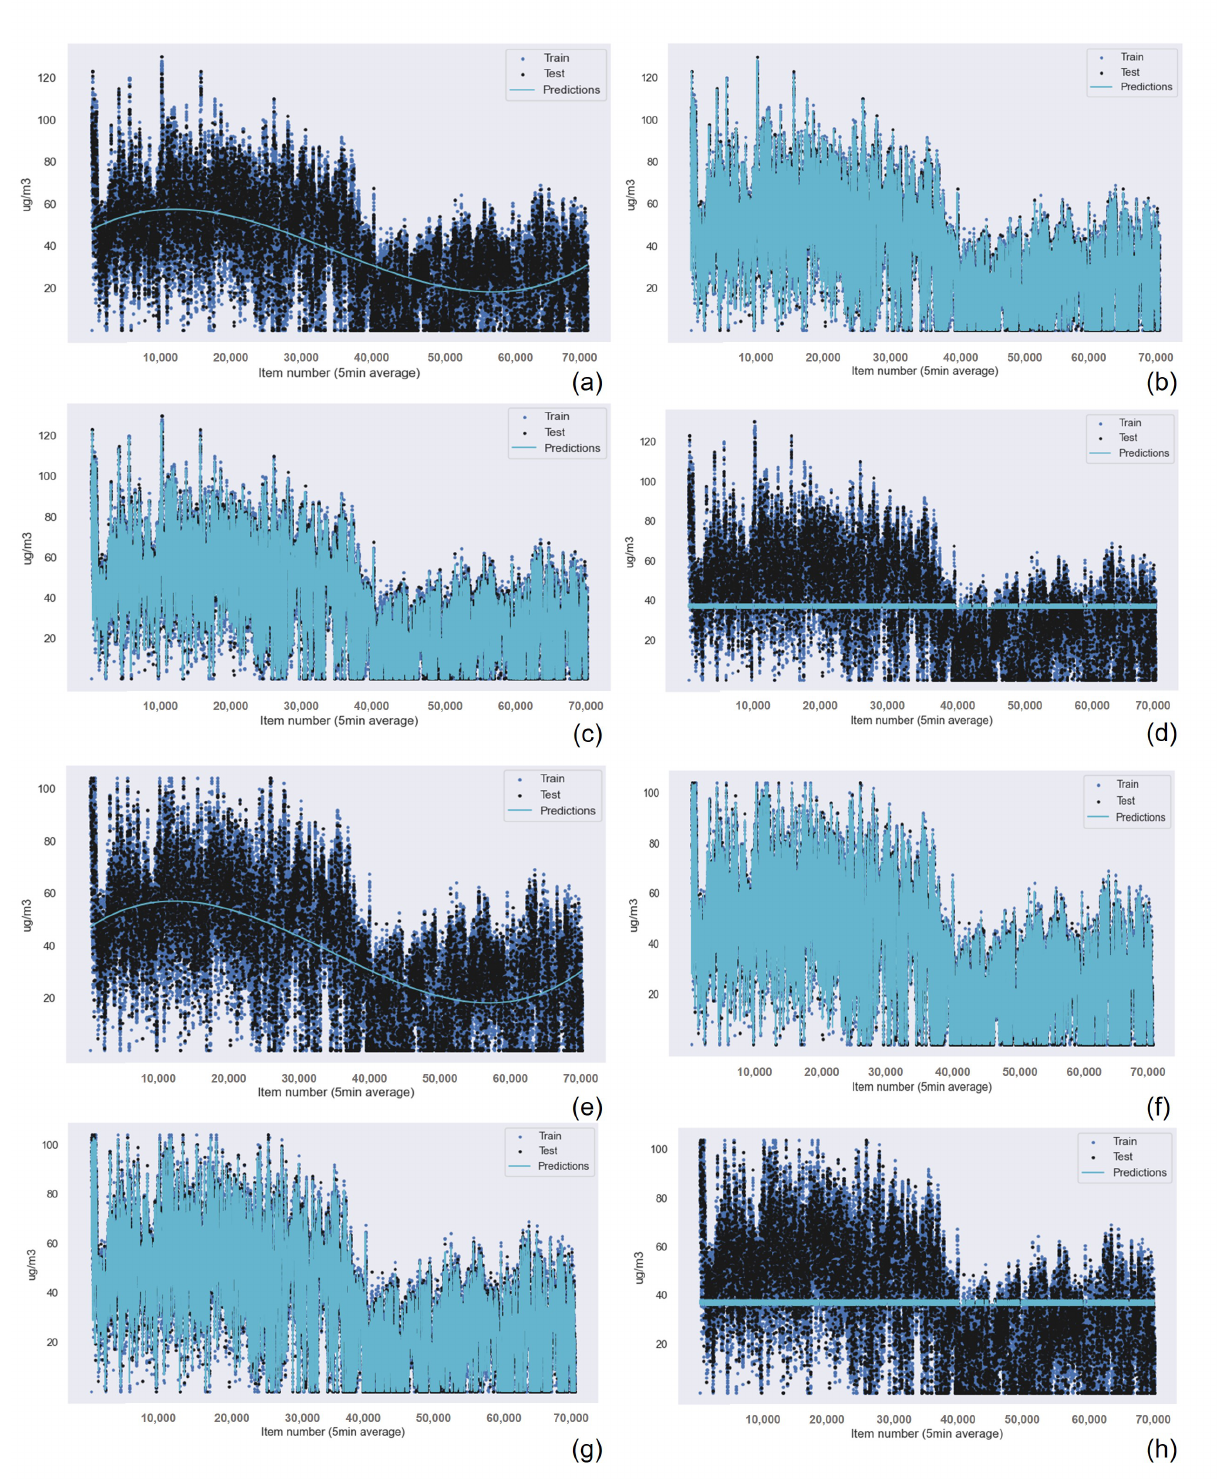
Figure A6. O 3 results with outliers for ( a ) Linear Regression ( b ) Random Forest Regression ( c ) KNN and ( d ) Support Vector Machine, and without outliers for ( e ) Linear Regression ( f ) Random Forest Regression ( g ) KNN and ( h ) Support Vector